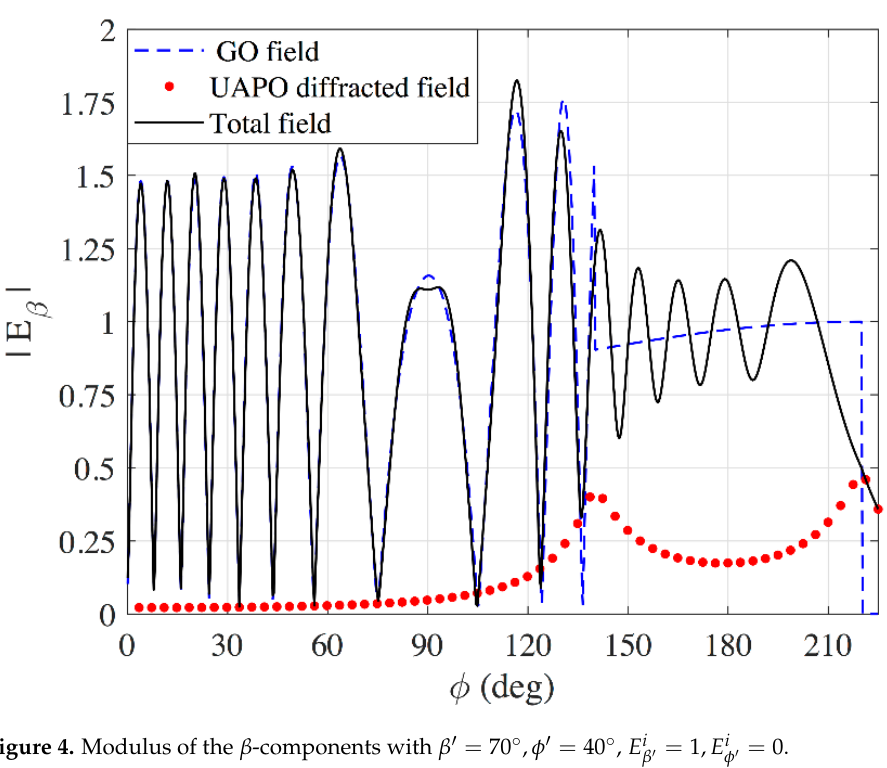
Figure 4. Modulus of the β -components with β (cid:48) = 70 ◦ , φ (cid:48) = 40 ◦ , E i